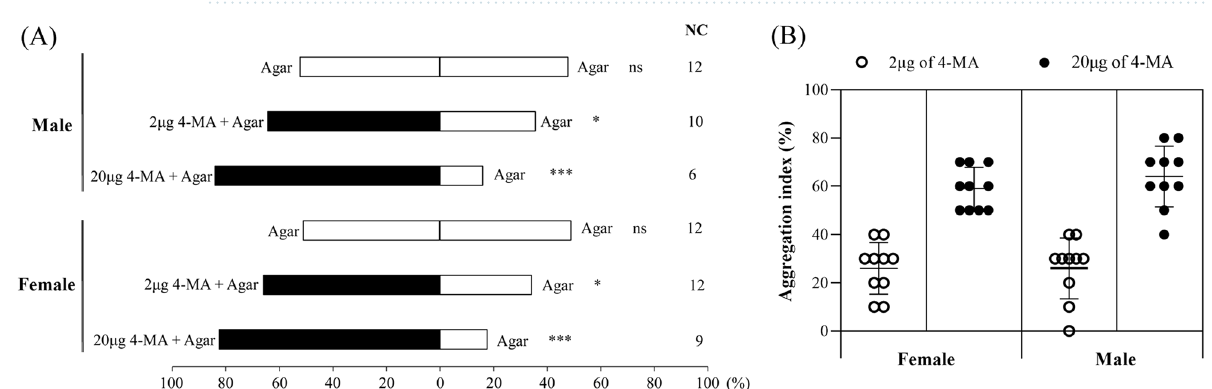
Figure 4. Behavioral responses of Protaetia brevitarsis in a Y-tube olfactometer ( A ) to anisole (An), n-heptanone (nH), 4-methylanisole (4-MA) and n-nonanone (nN) at a dose of 10 μg in 10 μL paraffin oil and ( B ) to 4-methylanisole (0.5, 1.0, 5.0, 10, 100 μg in 10 μL paraffin oil). N = 60 for each treatment. NC stands for numbers of non-response beetles. (Binomial tests: * 0.001 < P < 0.05; *** P ≤ 0.001).